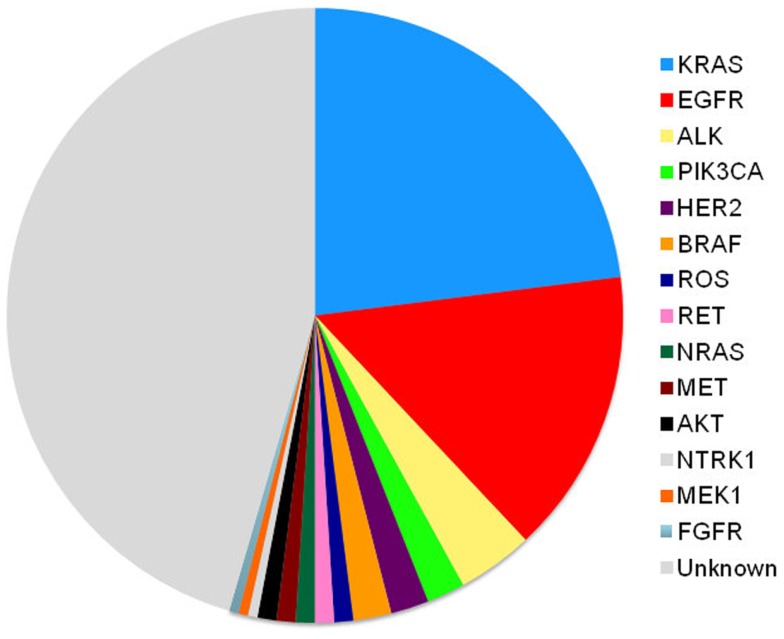
Oncogenic drivers in lung adenocarcinoma (27–29).